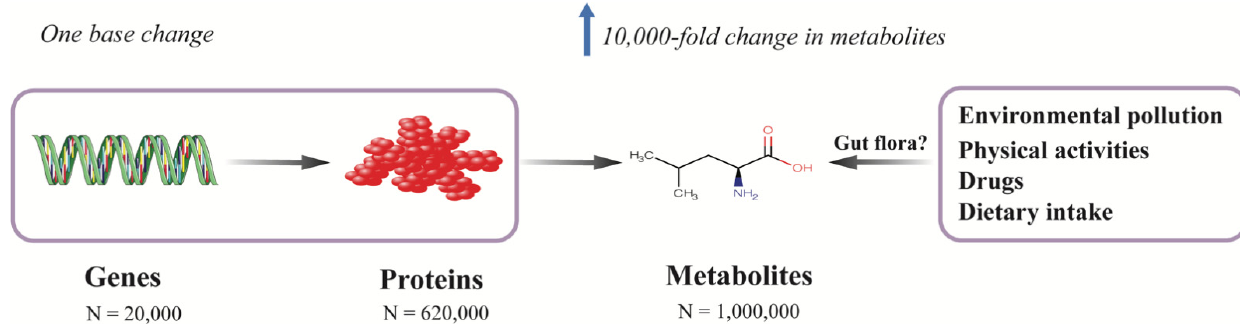
Figure 1. Metabolomics provide a comprehensive molecular profile of a phenotype by integrating both endogenous and exogenous information. Metabolites are the downstream products of the genome, transcriptome, proteome, and enzymatic reactions, which are also affected by environmental exposures, such as environmental pollution, physical activities, medications, and diet. The metabolome is closely correlated with genes in which even one single base change in a protein-coding gene can result in 10,000-fold change in the level of a metabolite. In contrast to the relatively simple chemical constitutions of genome (4 nucleotide bases) and proteome (20 proteogenic amino acids), the metabolome consists of thousands of different chemical classes and the number of metabolites is estimated to be around 1 million, while the number of genes and proteins are about 20,000 and 620,000, respectively. Thus, metabolomics provides a comprehensive molecular profile of a phenotype.